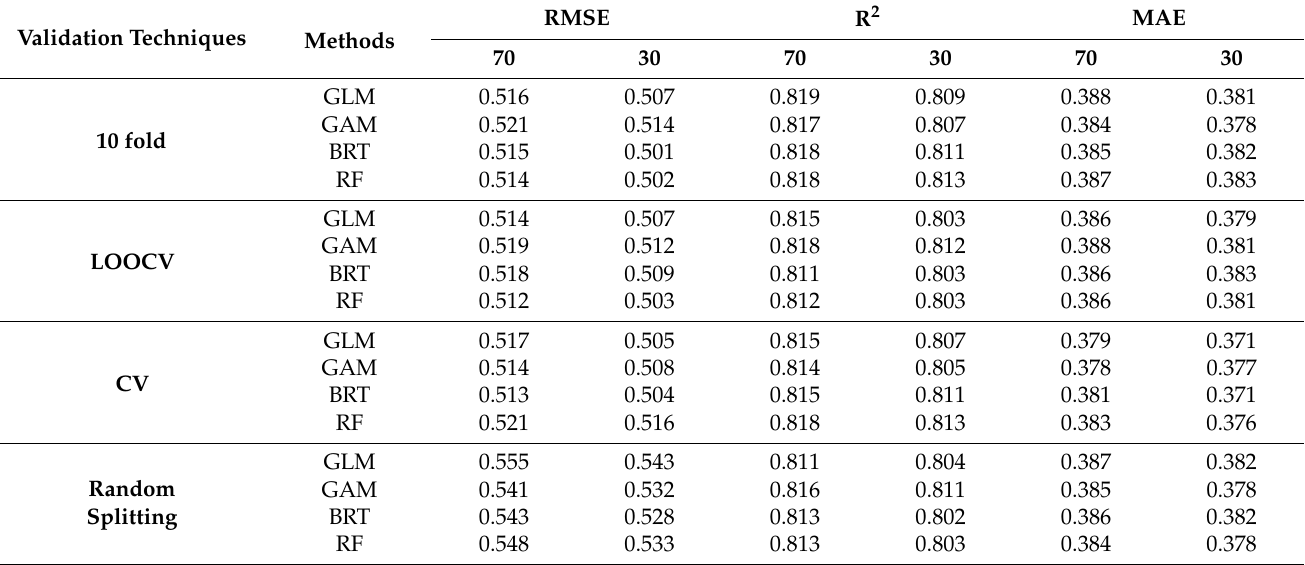
Table 7. Prediction performance of single-algorithm models when three validation techniques were